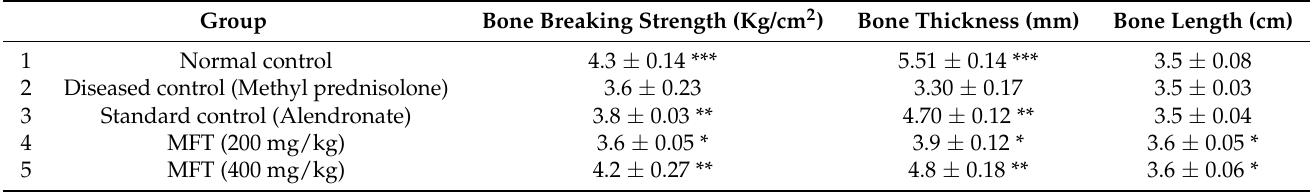
Table 1. Effect of Matricaria chamomilla flowers total ethanol extract (MFT) on bone breaking strength (Kg/cm 2 ), bone thickness (mm), and bone length (cm).